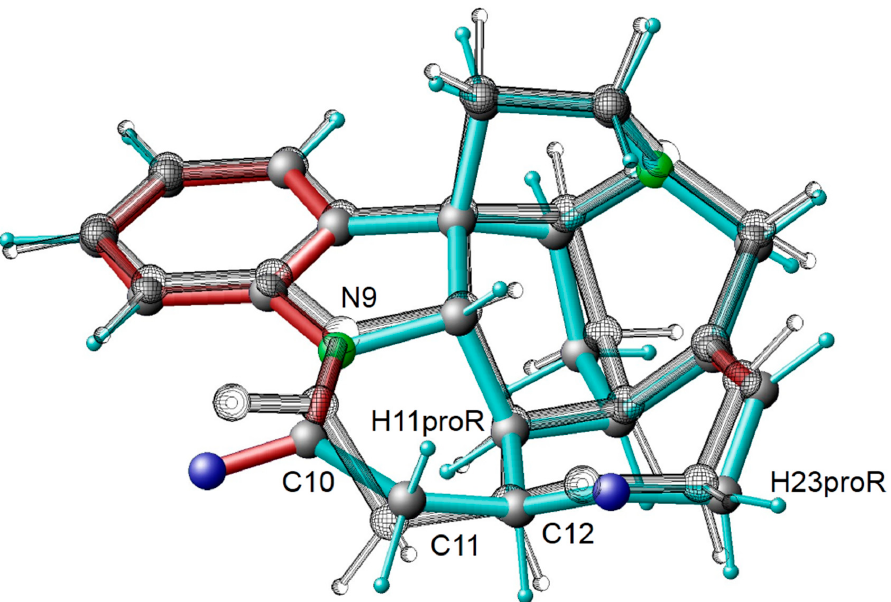
Figure 4. Overlay of two strychnine models with different G ring conformers. In color, the X-ray start structure with the torsion angle N9-C10-C11-C12 of − 41.7° and in black, the one of the G ring start structure with the torsion angle N9-C10-C11-C12 of − 41.7 ◦ and in black, the one of the G ring conformers with a torsion angle of 35.2°. conformers with a torsion angle of 35.2 ◦